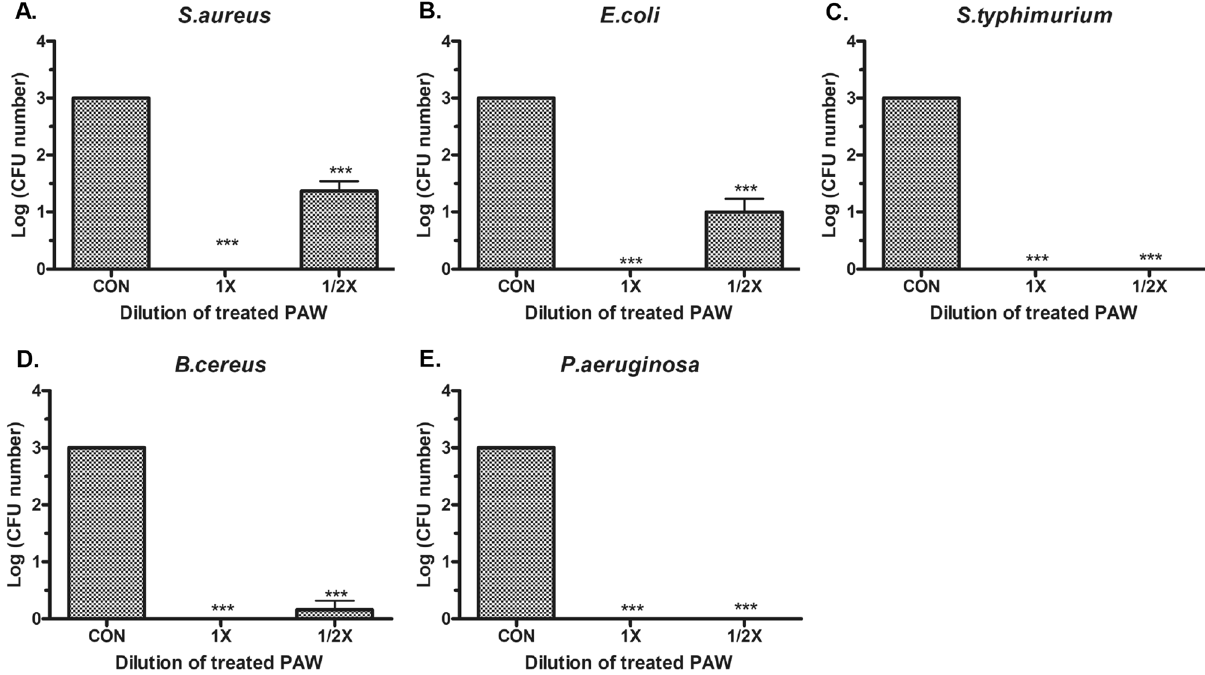
Figure 3. Bactericidal effect and effective concentration of plasma-activated water (PAW) for sterilization. (A) CFUs of ( A ) S. aureus , ( B ) E. coli , ( C ) S. Typhimurium, ( D ) B. cereus, and ( E ) P. aeruginosa treated with un-diluted (1 ×) and half-diluted (1/2 ×) PAW compared to those in untreated water samples (control, CON). Bacteria were treated for 5 min. Each value represents the average ± standard deviation of three replicate measurements. Three replicate measurements were used for statistical analyses. ***P <